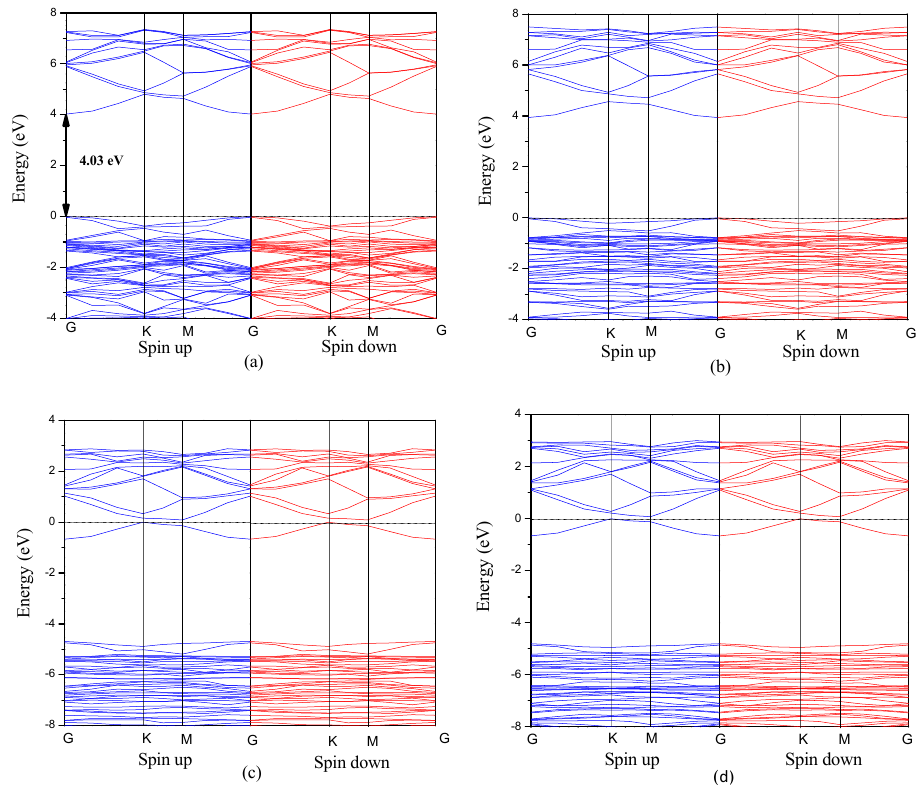
Figure 3. The band structures of ( a ) pristine ZnO monolayer; ( b ) 6.25 at%; ( c ) 12.5 at%; ( d ) 18.75 at% Al-doped ZnO monolayer.